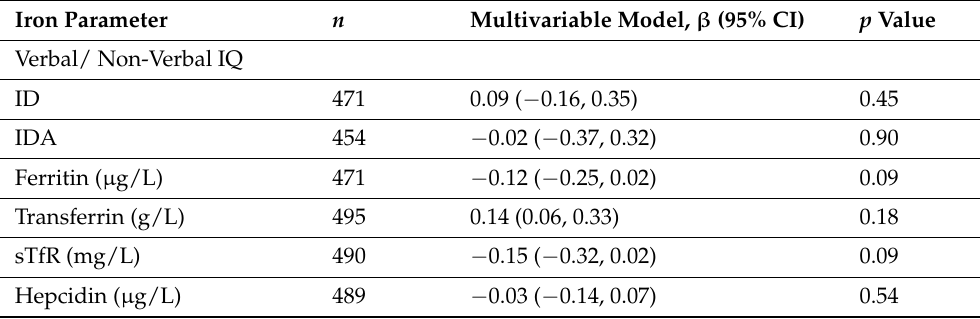
Table 6. Multivariable linear regression results for the association between measures of iron status and anemia at two years of age and cognitive and motor scores at five years of